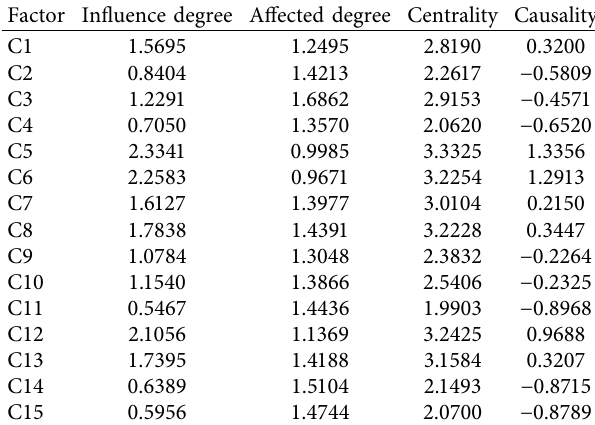
Table 5: Comprehensive impact matrix analysis.